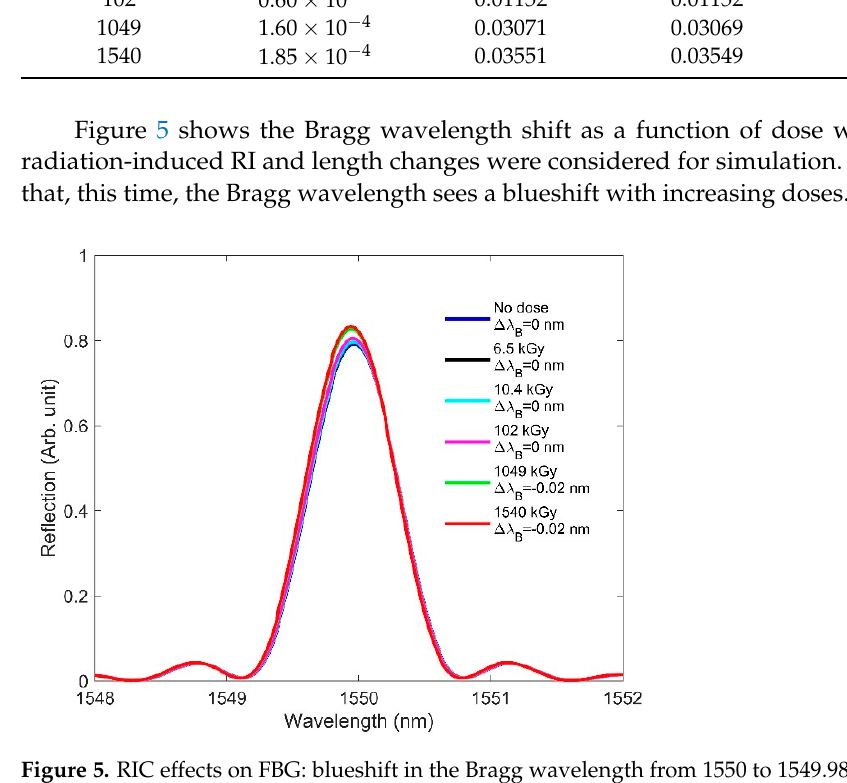
Figure 5. RIC effects on FBG: blueshift in the Bragg wavelength from 1550 to 1549.98 nm as the dose is increased from 0 to 1540 kGy, where ∆𝜆 (cid:3003) denotes the Bragg wavelength shift.